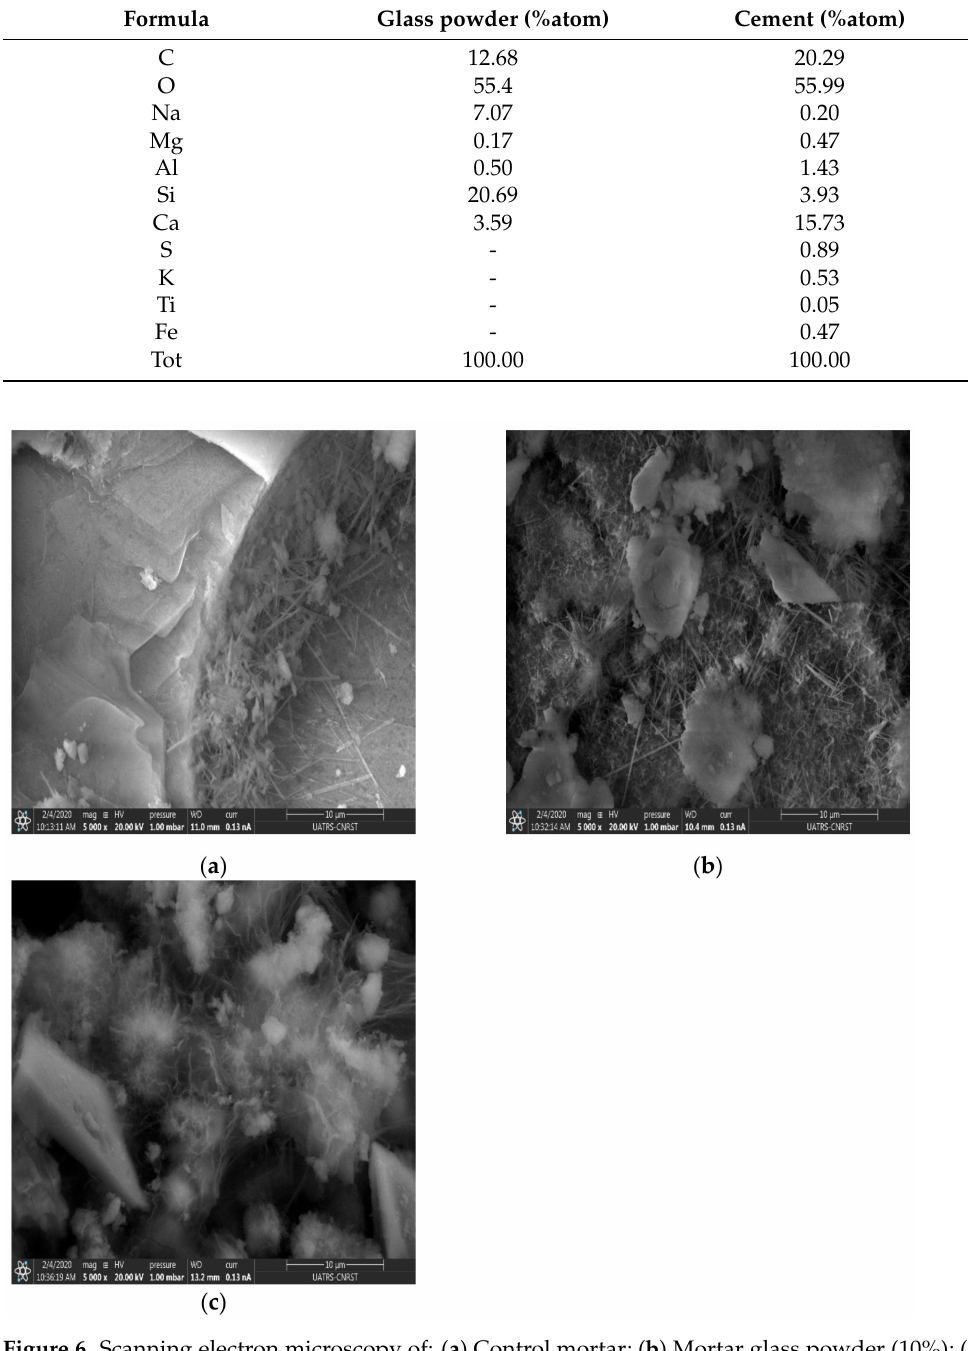
Table 1. Chemical composition of GP and Cement obtained from the EDX analysis.